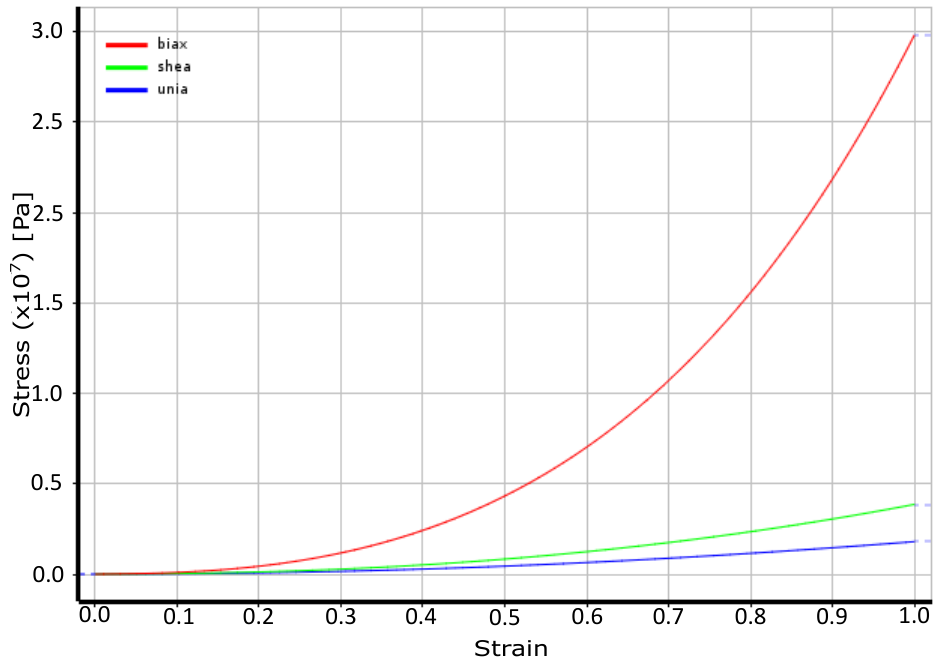
Figure 8. Behavior of the material according to the three-parameter Mooney–Rivlin model. According to Mcintosh and Anderson [30] in their work “A Comprehensive Tissue Properties Database Provided for the Thermal Assessment of a Human At Rest”, the density of the human colon corresponds to the value ρ = 1132 kg/m 3